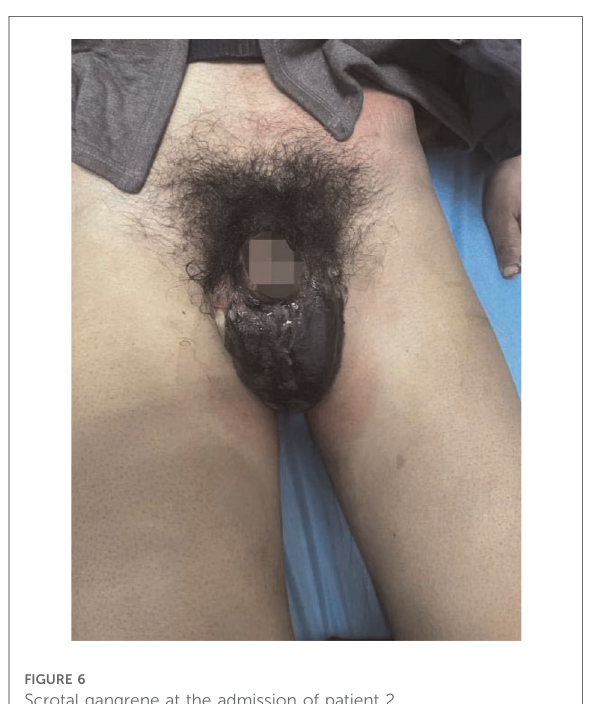
FIGURE 6 Scrotal gangrene at the admission of patient